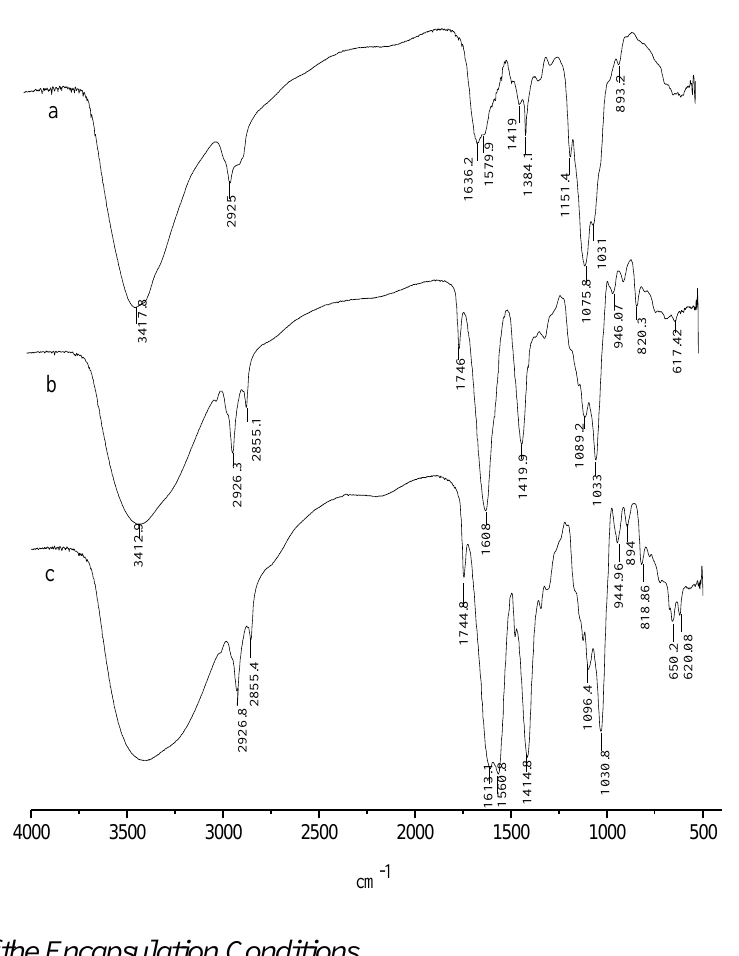
Figure 4. The infrared spectroscopy (IR) spectra of CaAlg beads ( a ), chitosan ( b ) and CACM ( c